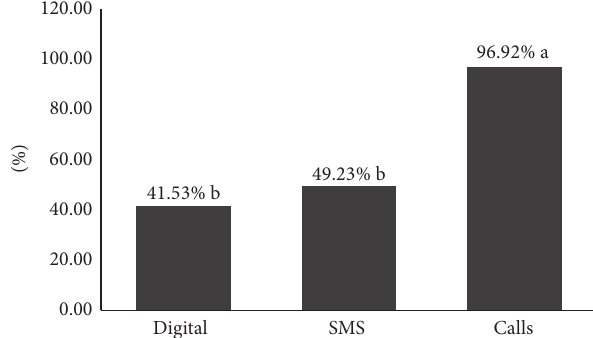
Figure 1: Comparison of preferred reporting methods. Proportions followed by different letters are significantly different ( 𝑝 < 0.05